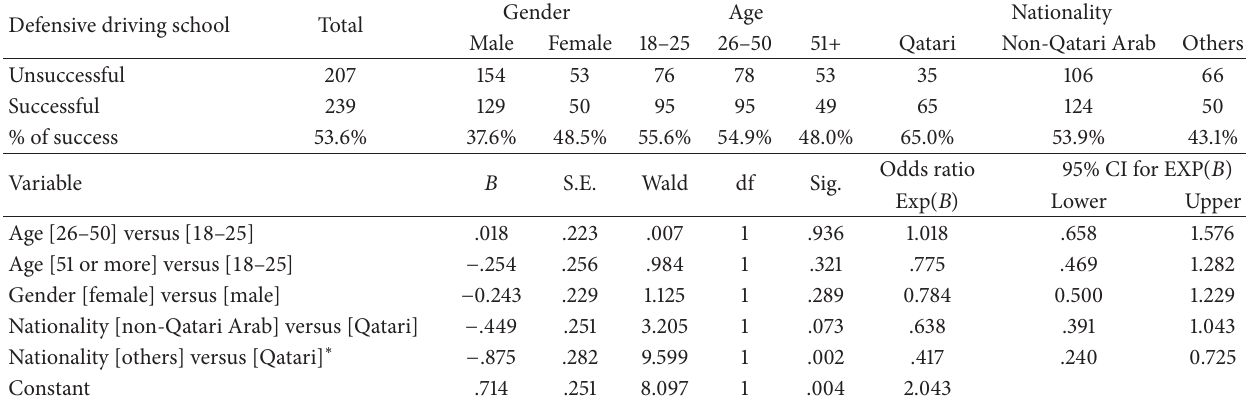
Table 11: Reported success and logistic model results for the defensive driving school